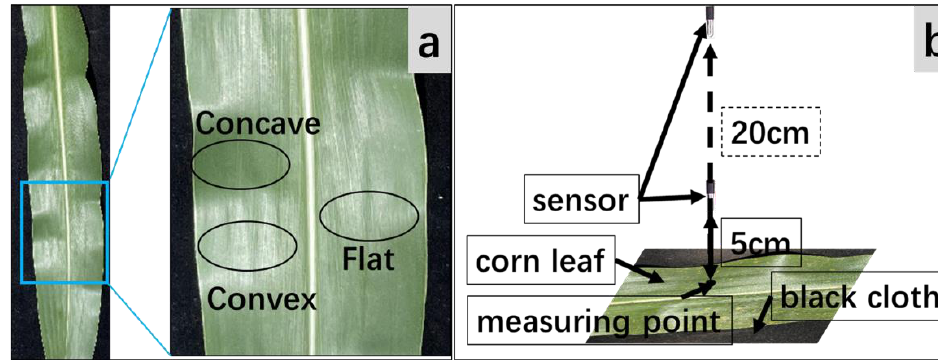
Figure 3. Illustrations of different leaf curvatures ( a ) and measured heights ( b ).